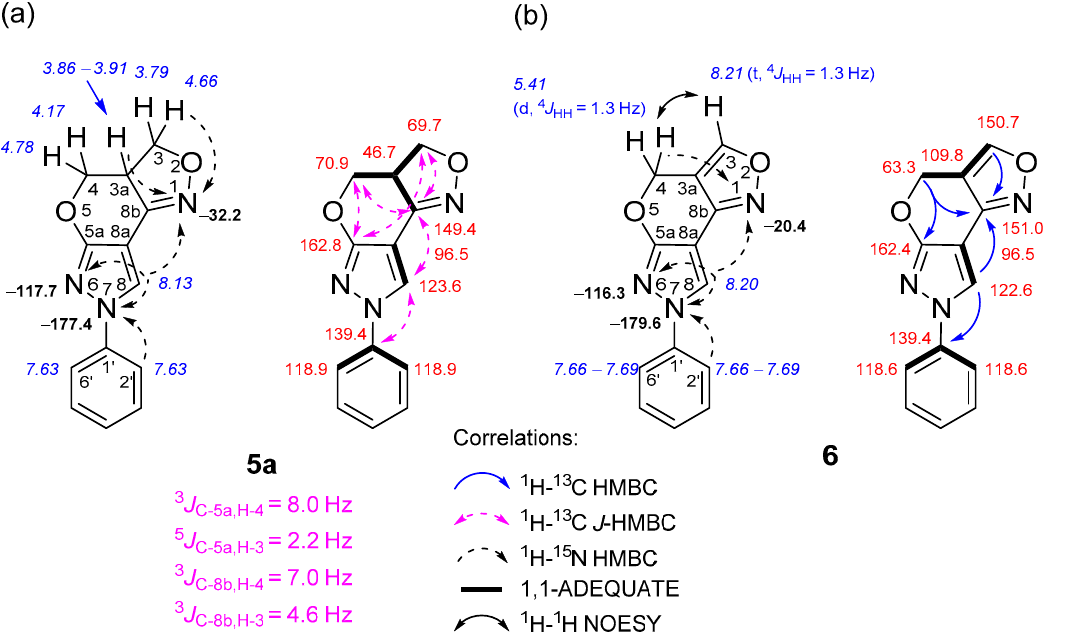
Figure 1. Relevant 1 H- 13 C HMBC, 1 H- 13 C J -HMBC, 1 H- 15 N HMBC, 1 H- 1 H NOESY and 1,1-ADEQUATE correlations and 1 H NMR (italics), 13 C NMR and 15 N NMR (bold) chemical shifts of compounds 5a ( a ) and 6 ( b ).